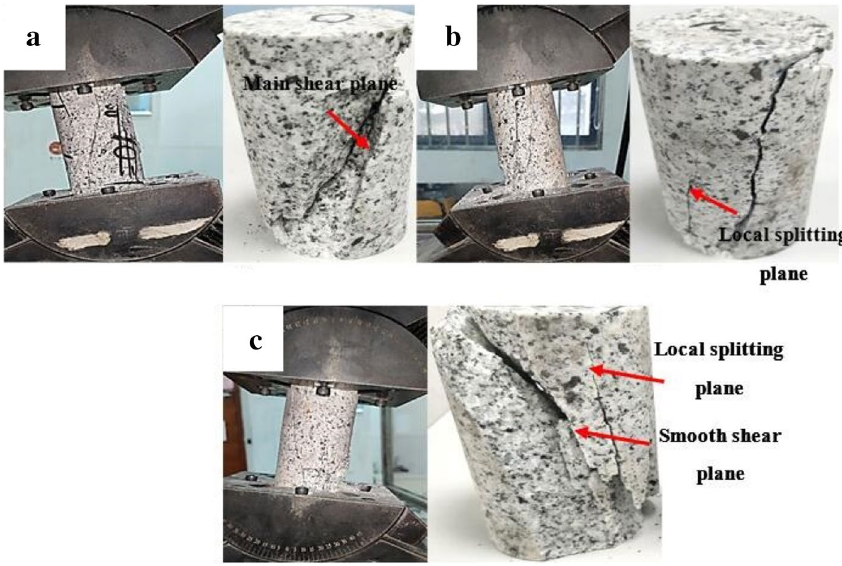
Figure 4. Granite specimen failure pattern at an inclination angle of 10°: ( a ) Experimental case 3–1; ( b ) experimental case 3–2; and ( c ) experimental case 3–3.